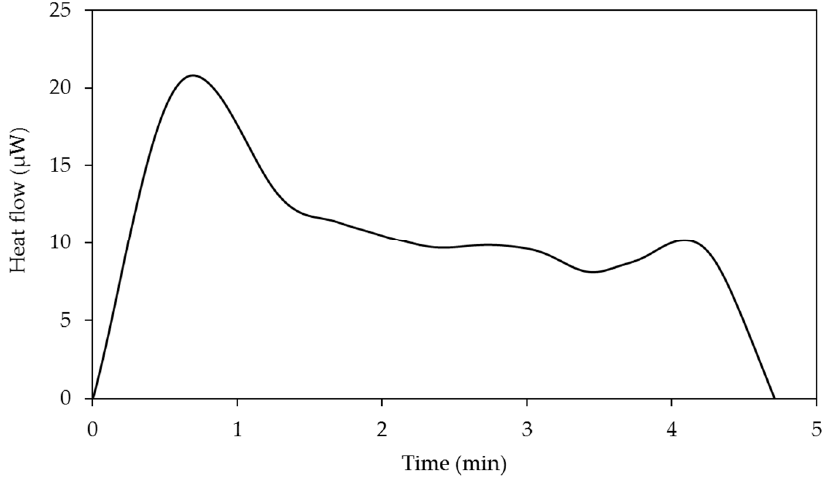
Figure 9. Thermogram of the adsorption calorimetric experiment (positive sign: exothermic).